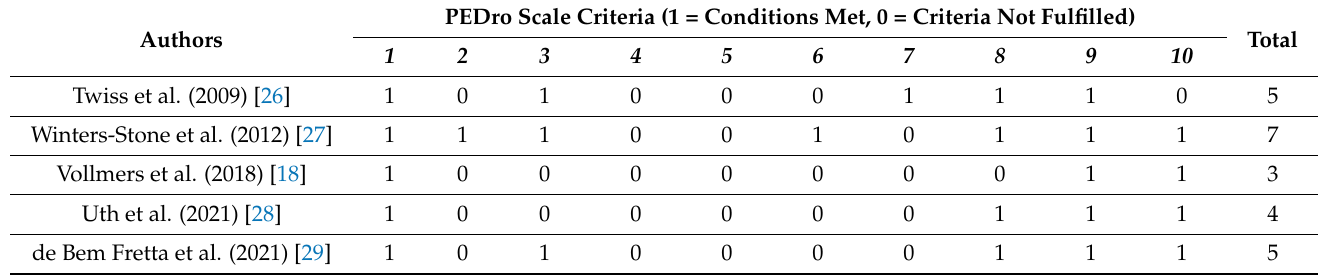
Table 2. The results of methodological quality assessment of RCTs based on the PEDro scale.